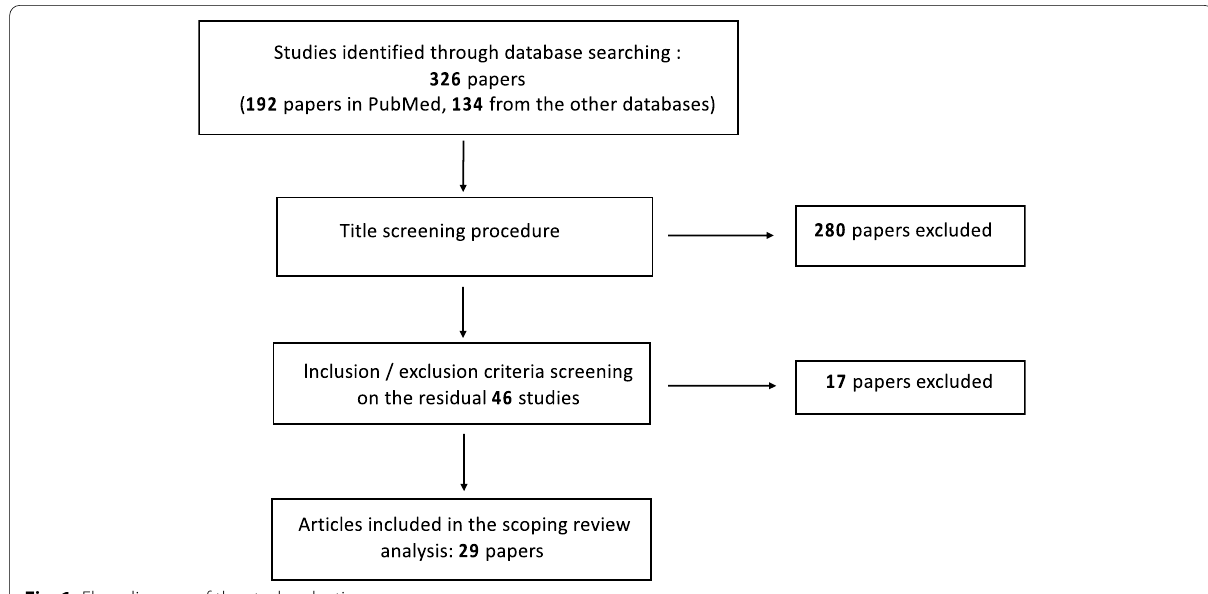
Fig. 1 Flow diagram of the study